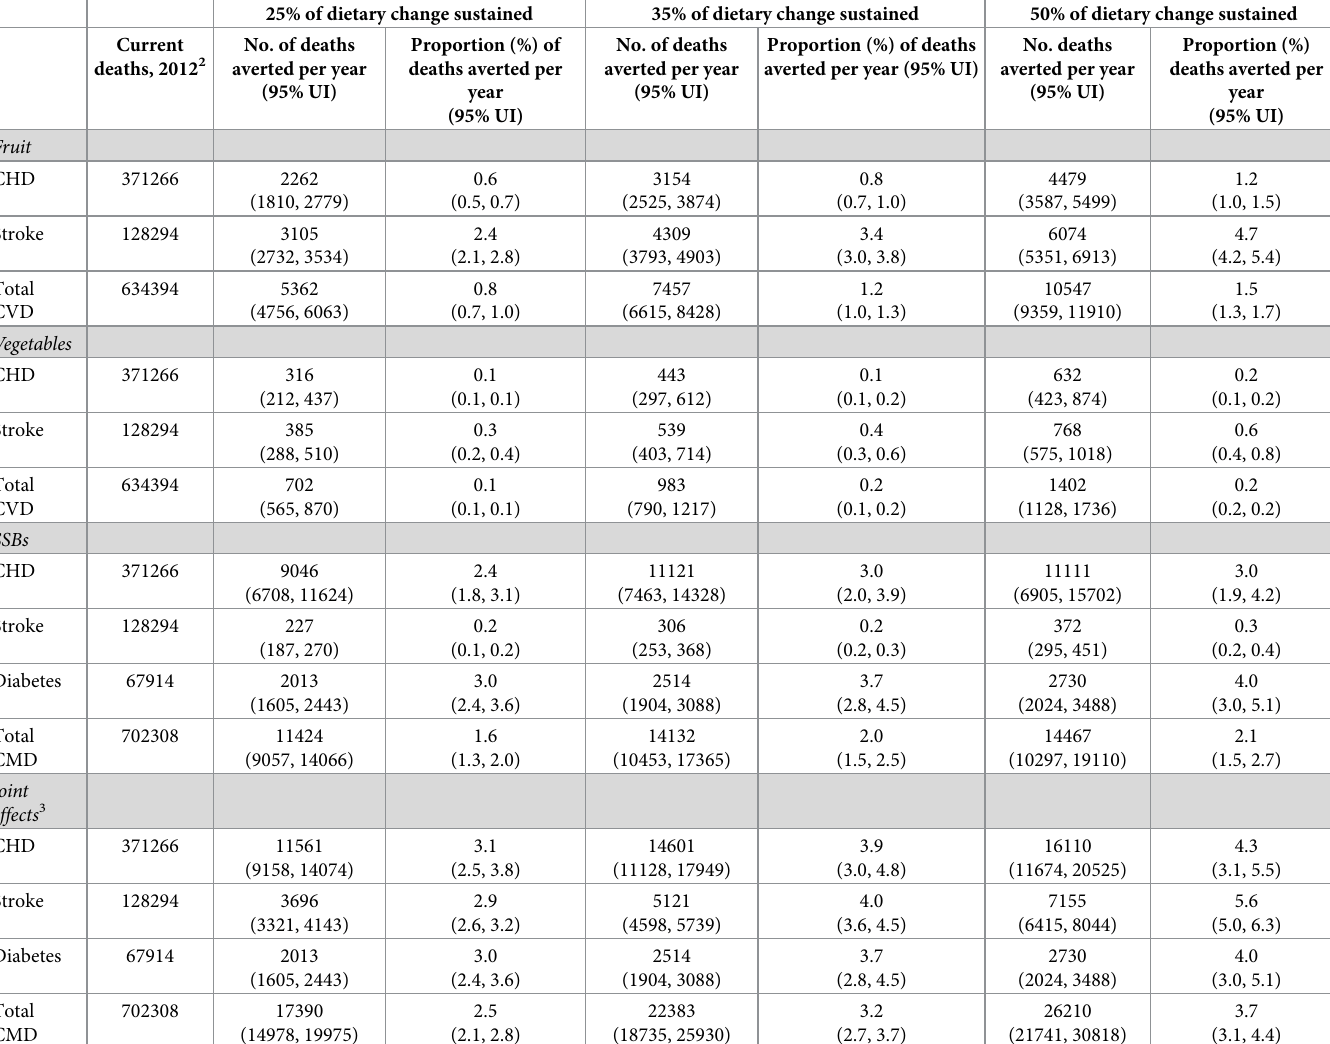
Table 3. Estimated cardiometabolic deaths averted associated with F&V provision and SSB restriction in US schools 1